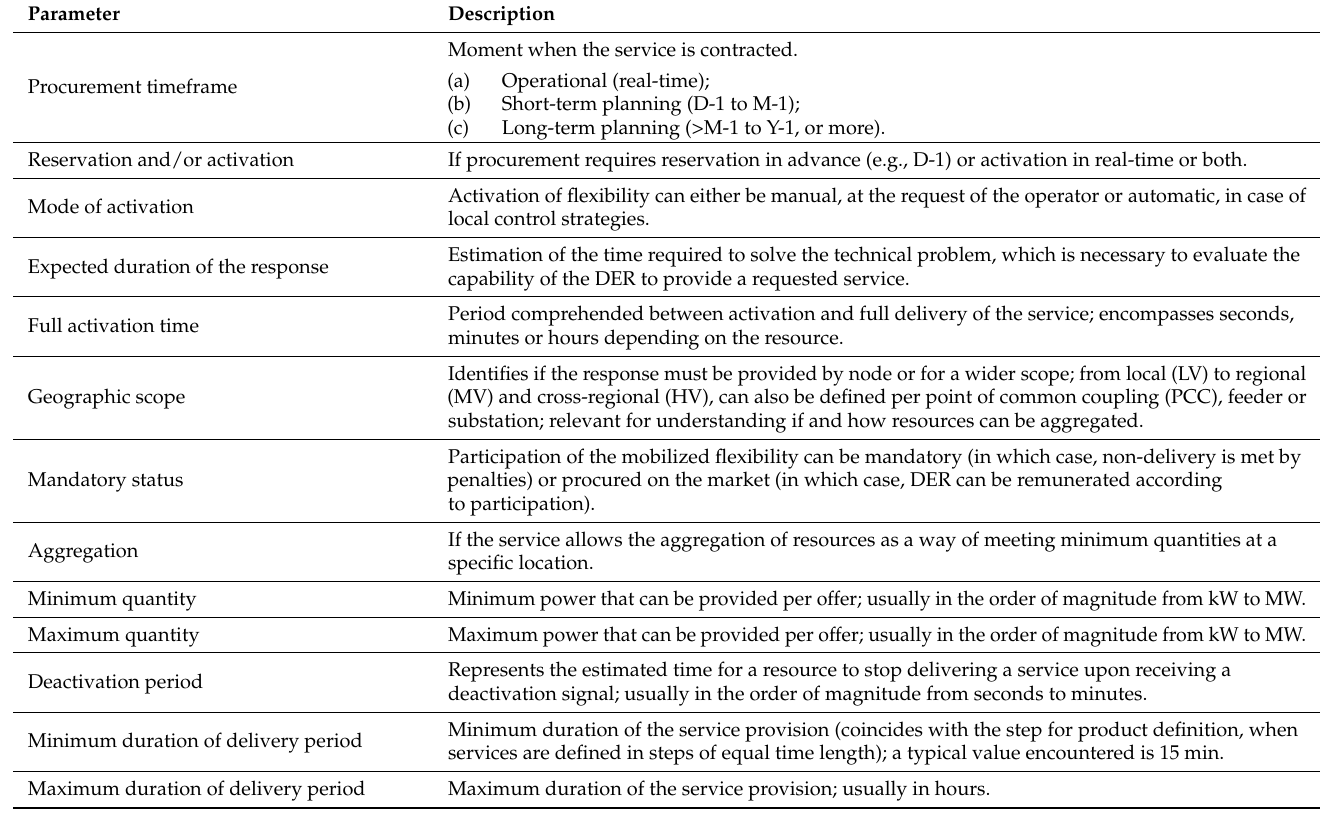
Table 5. Attributes for the characterization of a grid